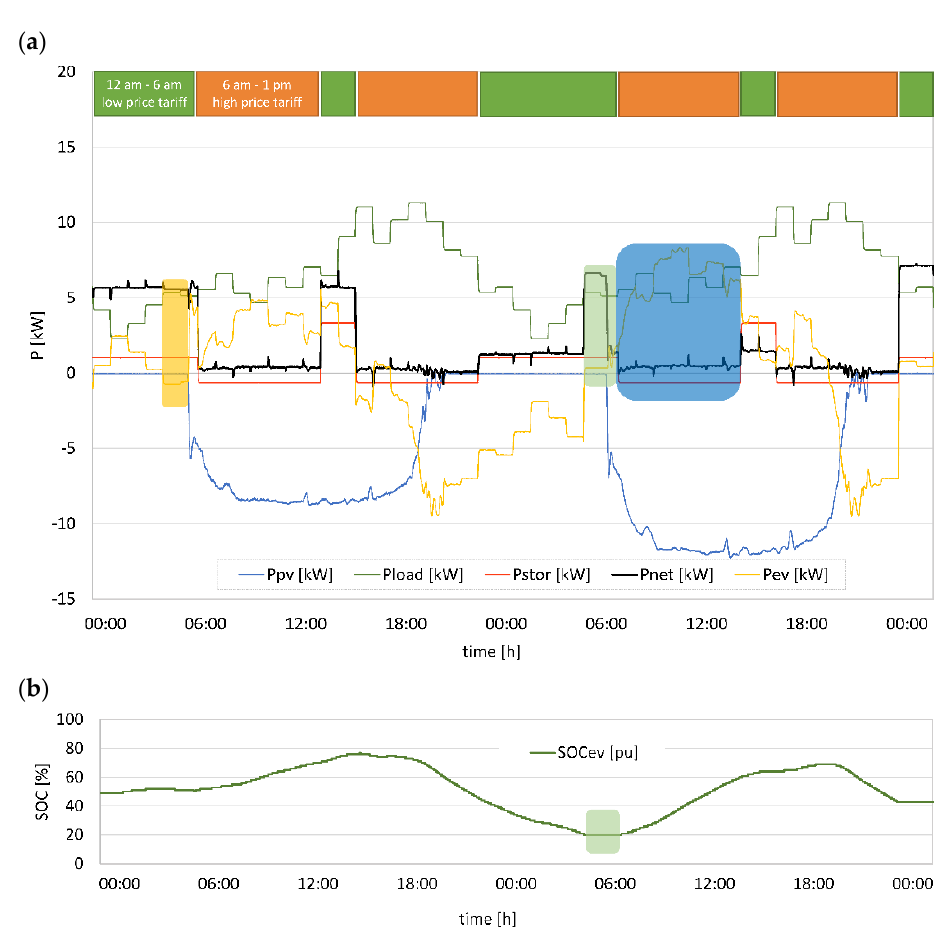
Figure 5. Scenario 2. EV connected to the prosumer installation during the whole analyzed duration.